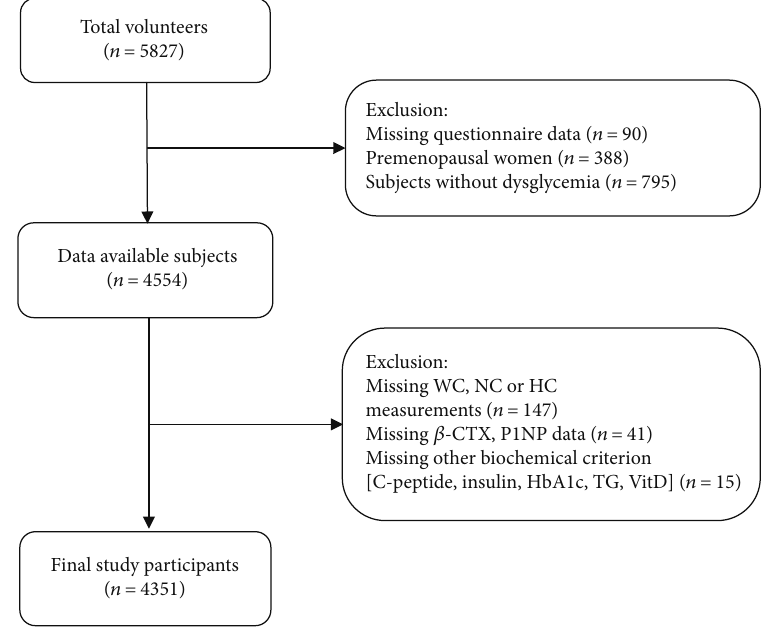
Figure 1: Flow chart of study participant selection (inclusion and